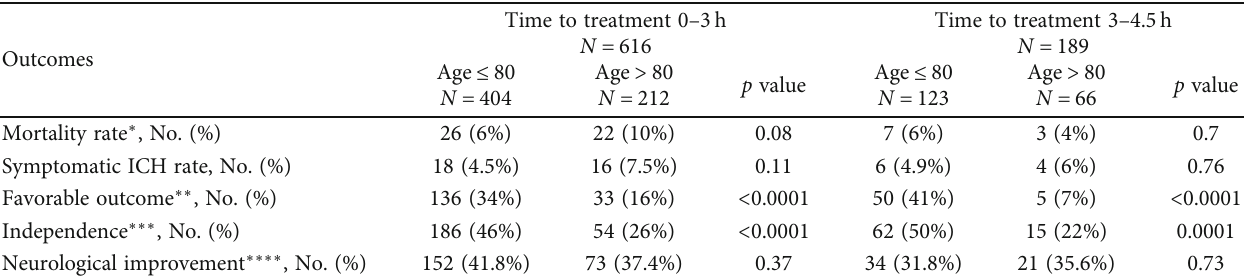
Table 2: Clinical and safety outcomes in the groups of aged > 80 and aged ≤ 80 according to treatment window.